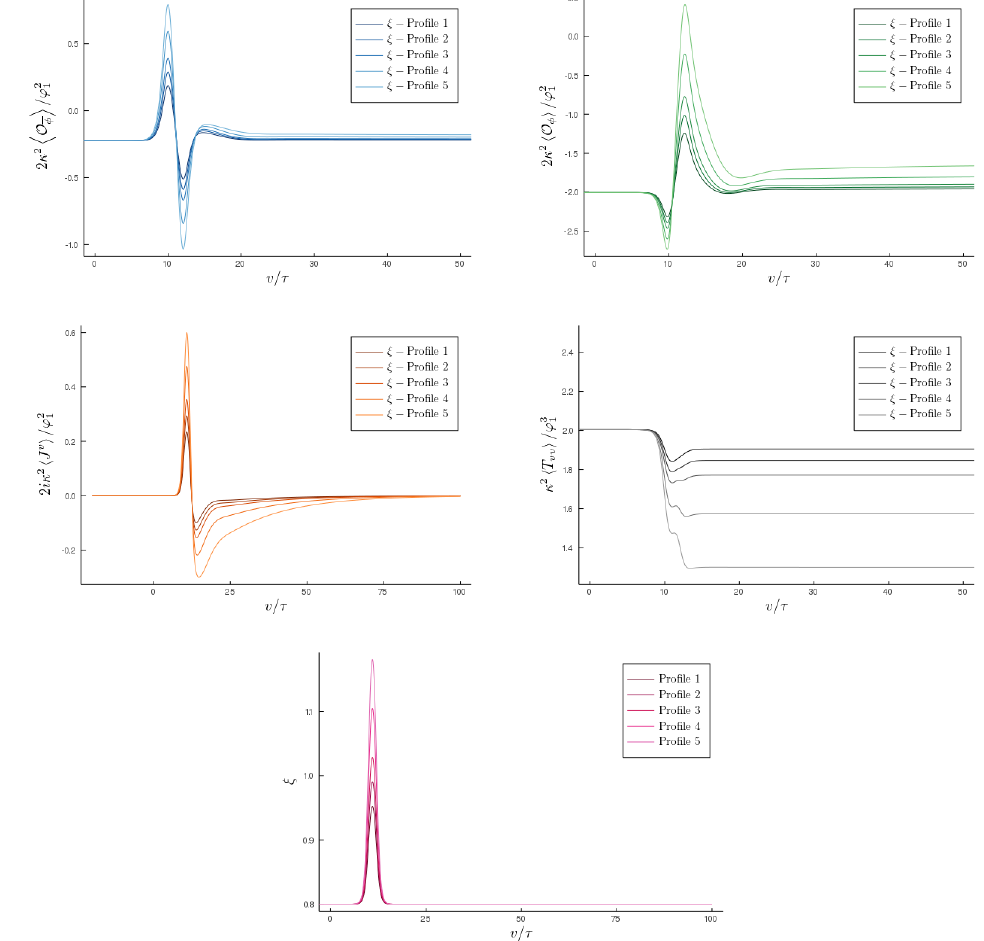
Figure 4: Expectation values 2.22 for a quench with profile 3.2 for ξ = { 1.0,1.05,1.1,1.2,1.3 } . The initial and final states are located at ξ = 0.8 m = 10 τ and ˜ v = 12˜ τ . We explore here the PT -broken and we set τ = ˜ τ = 0.25, v m m regime | ξ | > 1 going deeper and deeper into it. Even though the system spends significant amount of time in the PT broken regime it settles down to real and well behaved solutions once it re-enters the PT symmetric